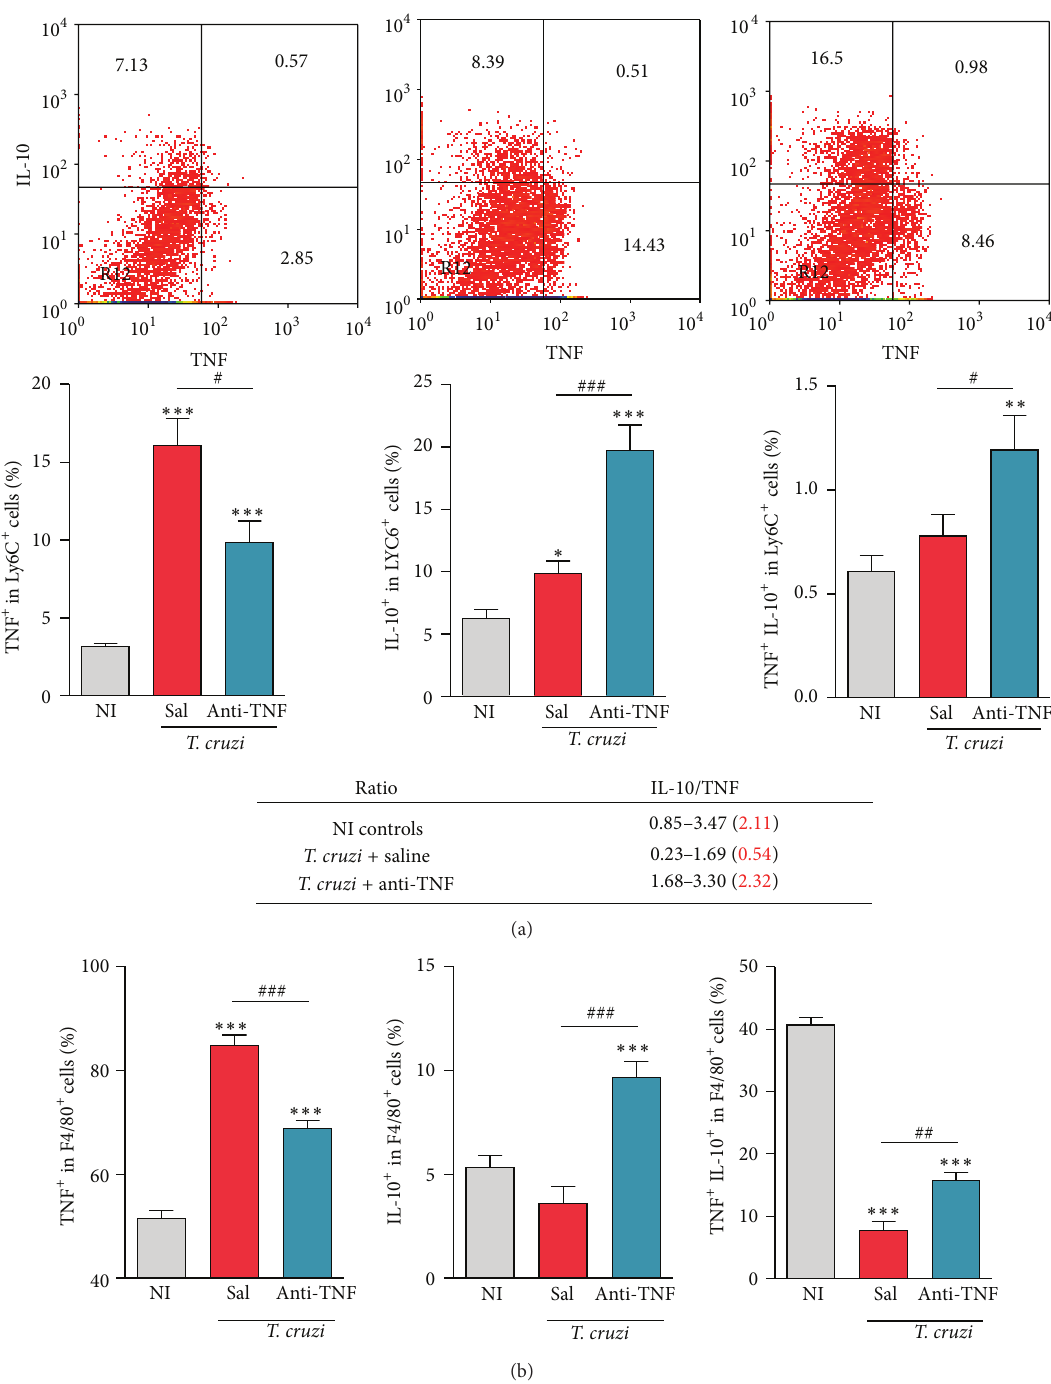
Figure 4: Anti-TNF therapy reduces the frequency of TNF + cells but increases the frequency of IL-10 + and IL-10 + TNF + cells among Ly6C +